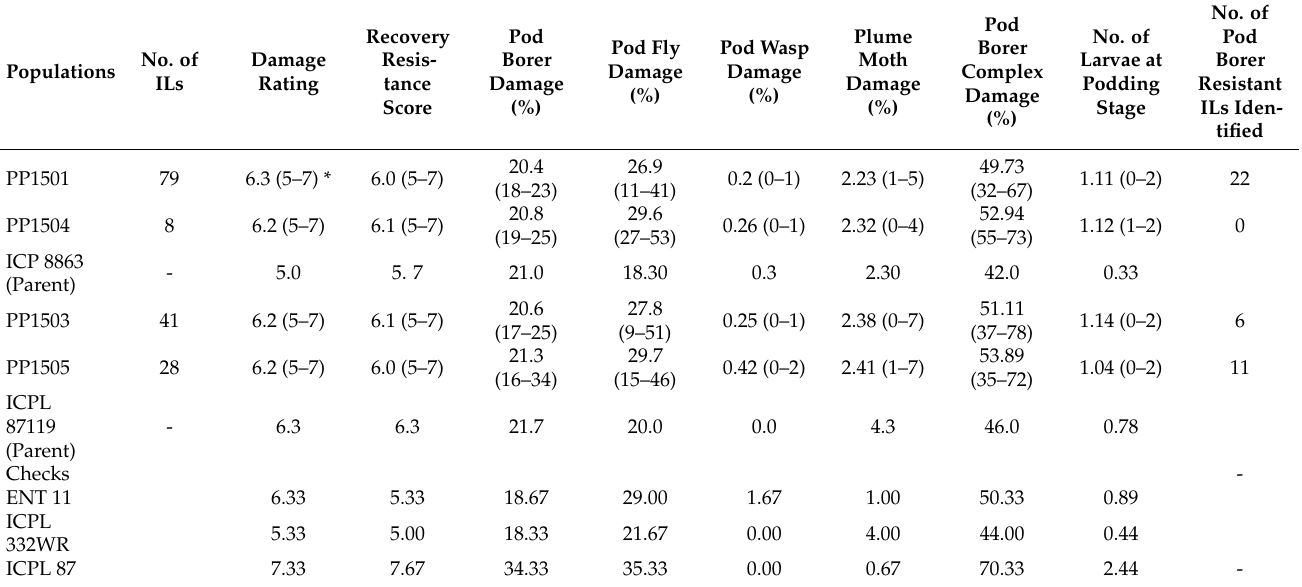
Table 3. Re-evaluation of selected introgression lines for resistance to pod borer complex during the 2019 rainy season at ICRISAT, Patancheru,